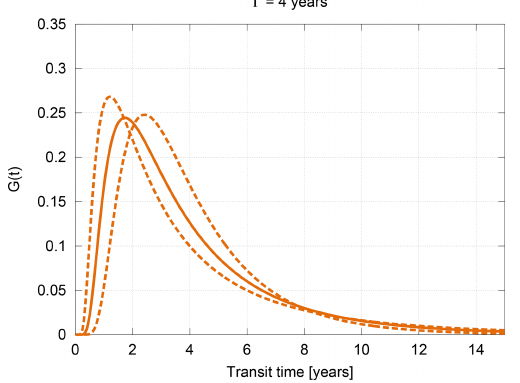
Figure 1. Sketch to illustrate the ratio of moments. The resulting age spectra from an inverse Gaussian with mean 4 years for values 2 of (cid:49) 0.7, 1.25 and 2.0 (cid:48)